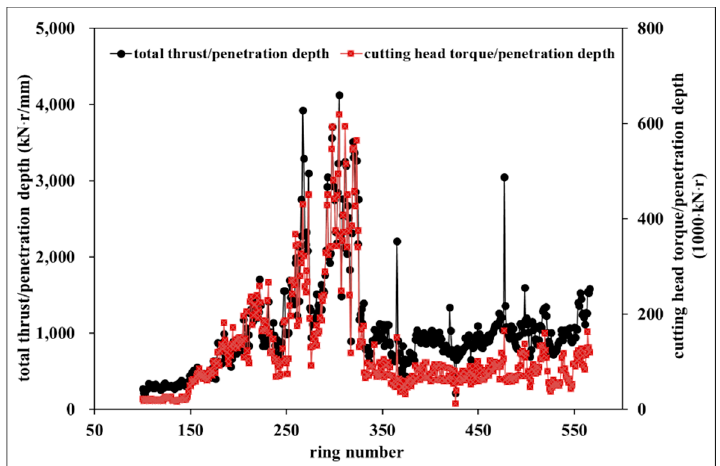
Figure 7. Changes of the two composite parameters at the Beijing south-to-north water diversion auxiliary project.